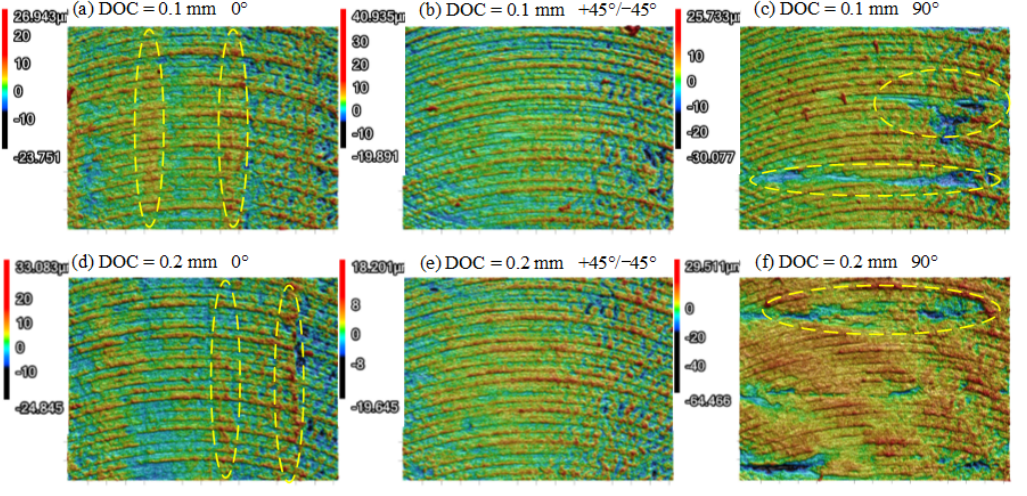
Figure 6. 3D morphologies of milled PEEK parts under different RAs: ( a ) DOC = 0.1 mm, RA = 0 ° ; ( b ) DOC = 0.1 mm, RA = +45 ° / − 45 ° ; ( c ) DOC = 0.1 mm, RA = 90 ° ; ( d ) DOC = 0.2 mm, RA = 0 ° ; ( e ) DOC = 0.2 mm, RA = +45 ° / − 45 ° ; ( f ) DOC = 0.2 mm, RA = 90 ° .